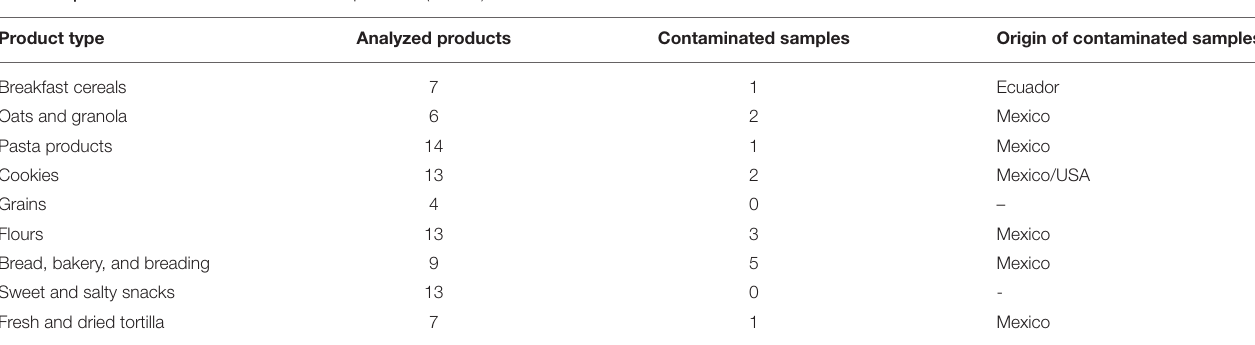
TABLE 2 | Gluten contamination of GF-labeled products ( n =